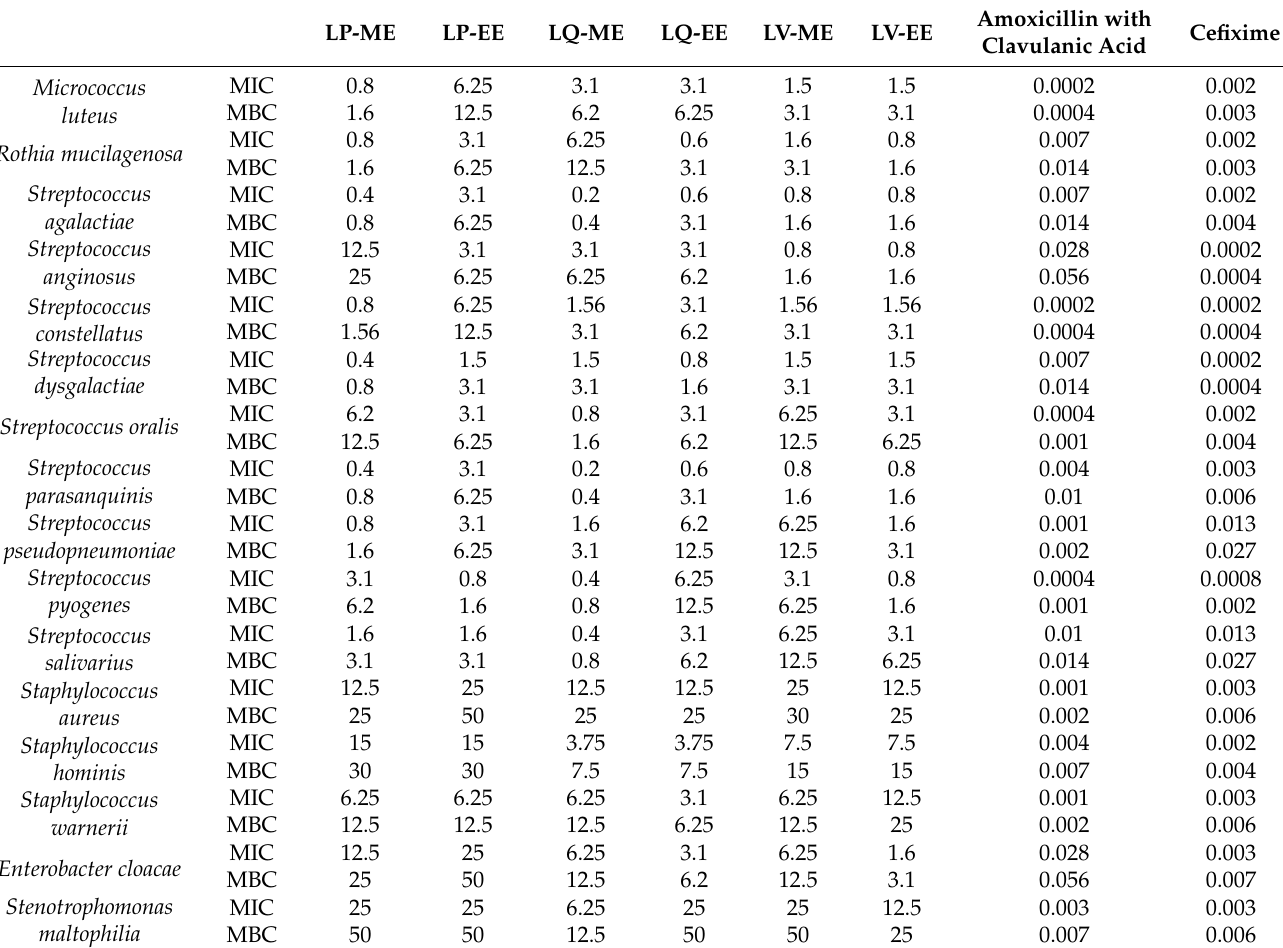
Table 5. Antibacterial activity of methanolic and ethanolic extracts of tested Lactarius species